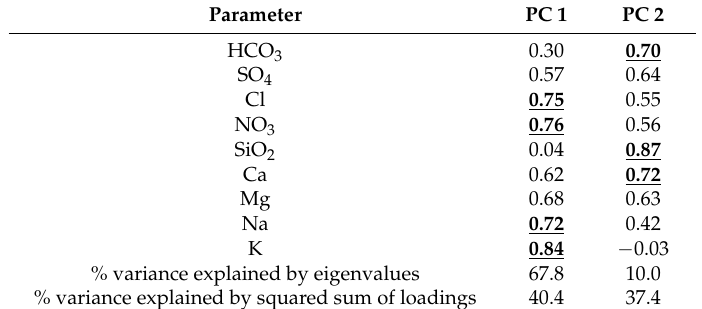
Table 2. Results of the principal component analysis for groundwater parameters after varimax rotation.